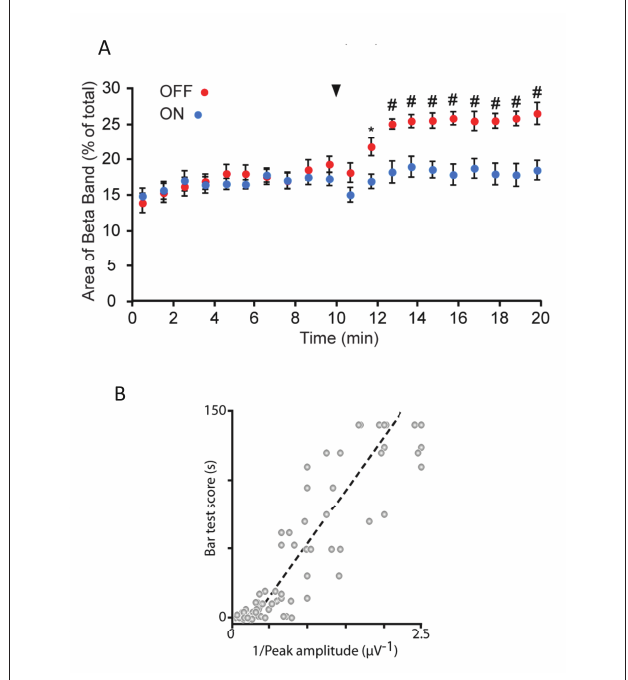
Figure 3 | Cortical effects and the recovery from akinesia. In (A) the average percentage power in the beta band of the EEG is plotted for all nine rats in the study. Each rat is recorded in two conditions. The red symbols are from a day when the rats were treated with Dl and D2 blockers after 10 min in the recording chamber and for 10 min thereafter. The blue symbols represent 2 days later when the animals were again in the same recording chamber but with the stimulation ON (120 Hz and less than 80% of the threshold for movement). The beta power increase caused by the drugs is blocked. In (B) we show the inverse relationship of the effect to the stimulus strength. The threshold for a cortical evoked potential is just below 2 μA (0.5 on the scale). The animals come off the bar very quickly when the stimulus is above threshold and the recovery is directly related to the inverse of the stimulus power (more effective akinesia prevention is proportional to higher current ( r 2 =